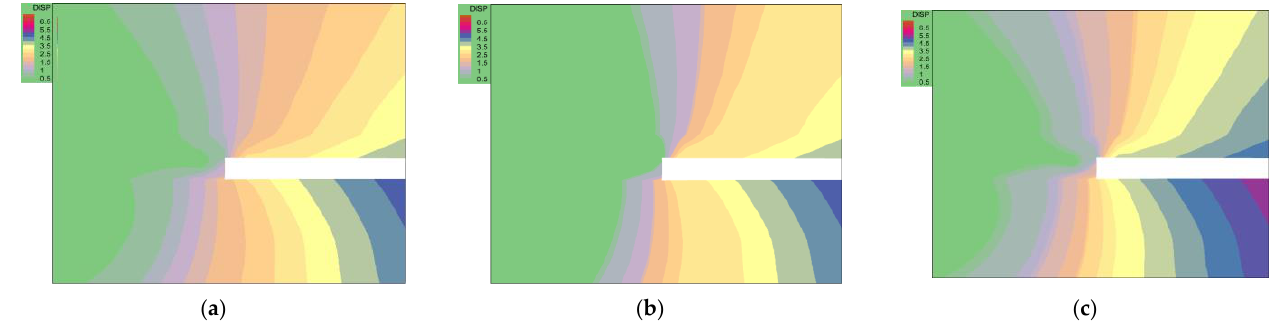
Figure 6. Evolutionary law of displacement field of surrounding rock with different basic top thickness-to-span ratios in the advancing direction of a stope. ( a ) Thickness-to-span ratio less than 0.5. ( b ) Thickness-to-span ratio of 0.5. ( c ) Thickness-to-span ratio greater than 0.5. Similarly, from the analysis of the effect of the overlying basic roof thickness-to-span